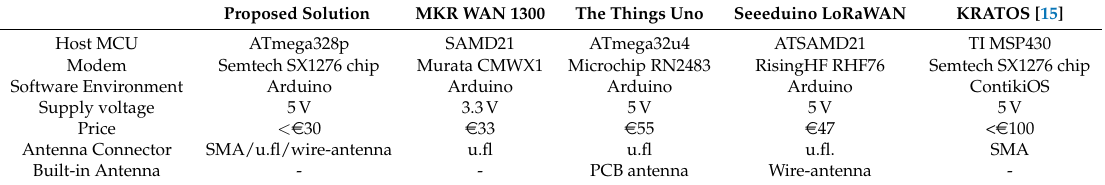
Table 1. Overview of the benchmarked sensor